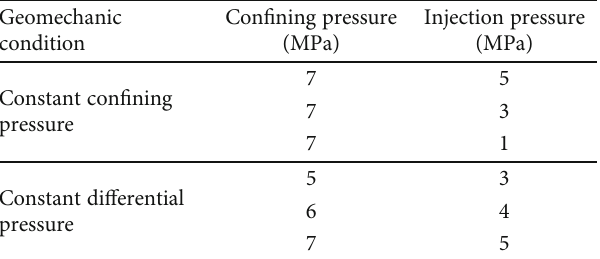
Table 1: Testing geomechanic